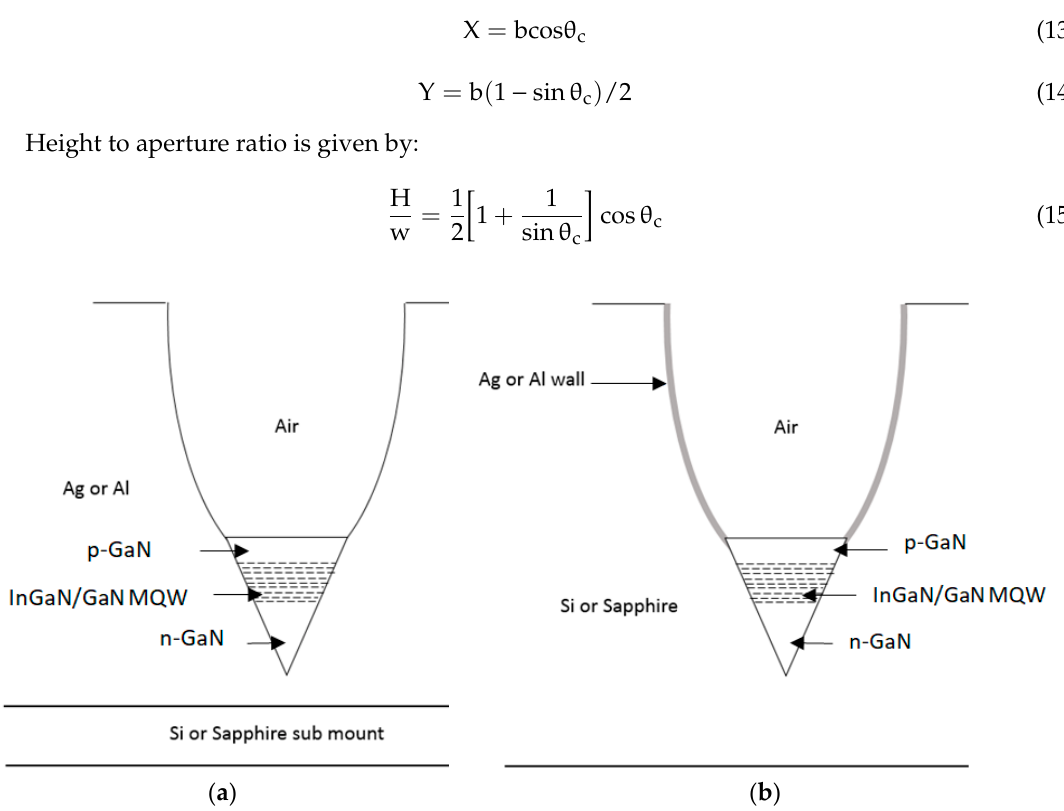
Figure 11. Views of the CPC structure. ( a ) a reflective cavity into Ag or Al material; ( b ) a CPC with Ag or Al reflective wall inside a Si or Sapphire material.